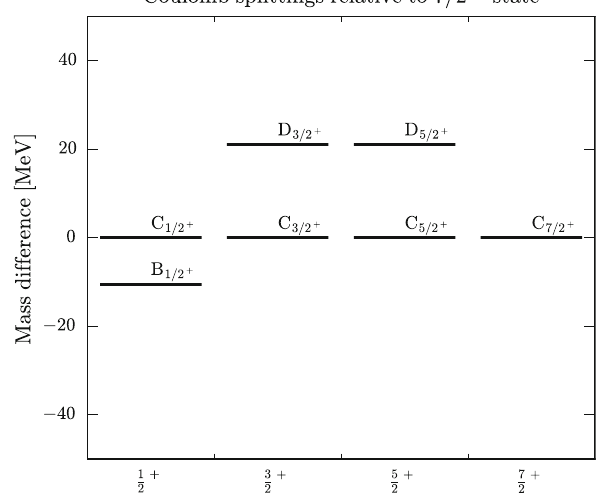
Fig. 5 Expanded view of B , C and D states of bbb in Fig. 4. The har- monic oscillator and Coulomb potential are sufficient to qualitatively reproducethepatternofsplittingspresentedinFig.11inRef.[54].How- ever, quantitatively our pilot-study splittings are about twice